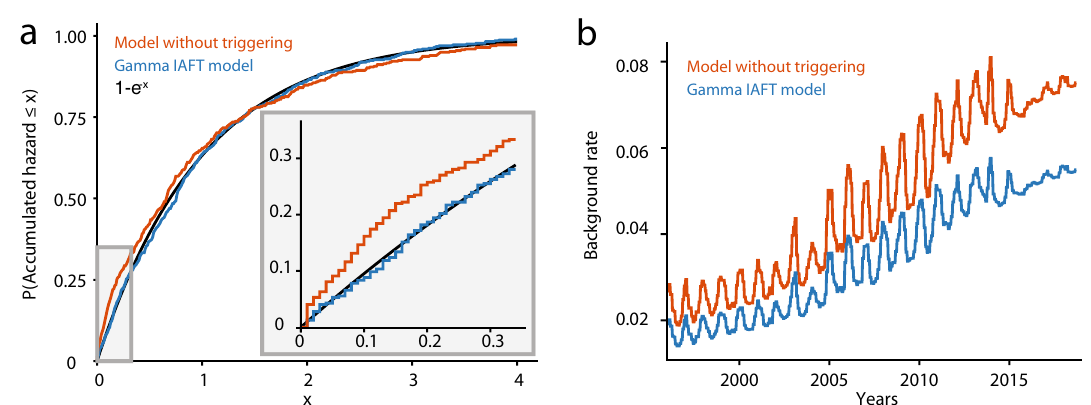
Figure 3. The effect of clustering in Groningen. ( a ) The left tail of the empirical distributions of the integrated hazard over each interevent period for the Exponential ( k = 1 , red) and the Gamma (blue) IAFT models. These accumulated hazards should follow a unit Exponential distribution (black; Cox–Snell test 58 ). The number of interevent times with a low accumulated hazard is overestimated in the ( k = 1 ) -model (inset: zoom), thus this model results in fewer short interevent times than observed in Groningen. ( b ) Background rate (events per day) based on the ML-estimates of the Exponential IAFT (red) and Gamma IAFT (blue) The estimated value of the cap variable indicates that all faults in the Loppersum region became critically stressed at the end of 2007, when the total compaction was 0.24 m in this most active region (Fig. 2a). Our non-stationary Gamma IAFT model proved to fit the multi-year seismicity rate and the temporal event clus- tering in the Groningen catalog very well. We have validated this by analyzing the distribution of the total accumu- lated (or integrated) hazard during the interevent period. It should follow a unit Exponential distribution when the true interevent-time distribution is used 58 , see Fig. 3a and “Discussion”. We can statistically accept that this is the case (Kolmogorov–Smirnov test, p = 0.68 ). Furthermore, we did verify randomness of the model residuals over time